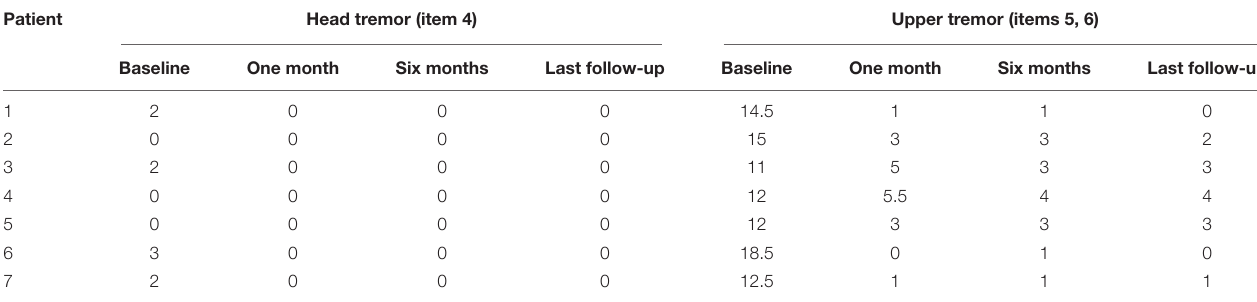
TABLE 3 | Essential tremor rating scale raw scores of each patient (DBS ON). Patient Head tremor (item 4)